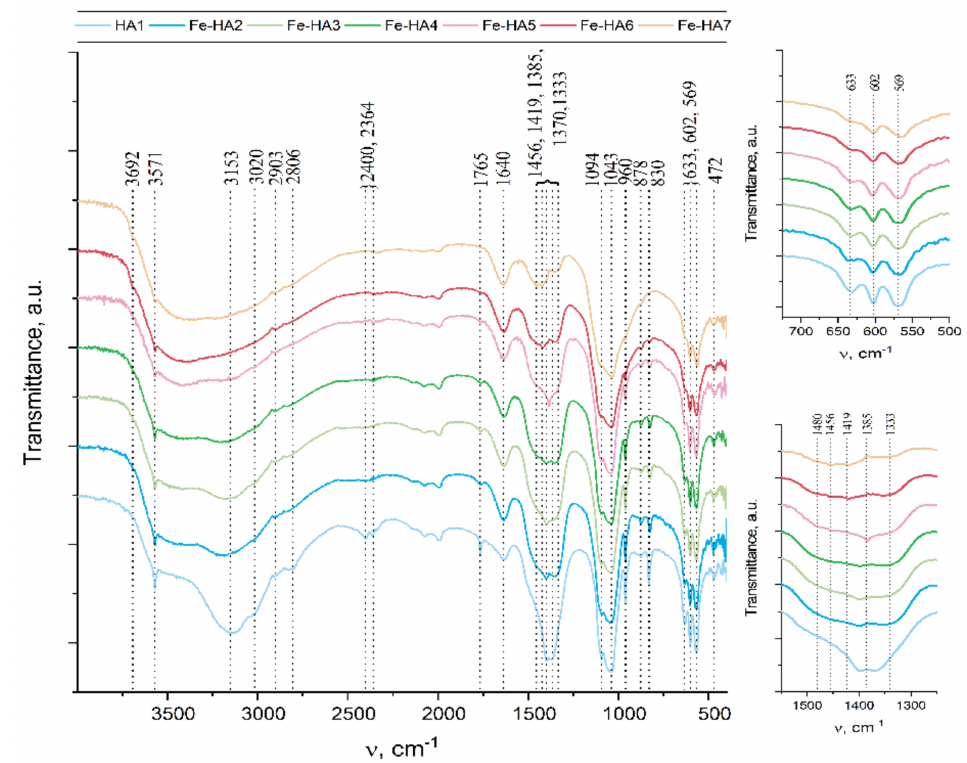
Figure 2. FTIR data of the Fe-HA